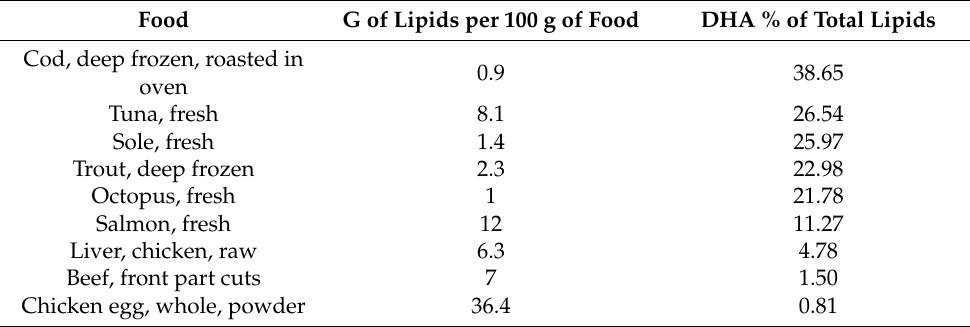
Table 4. Docosahexaenoic acid (DHA) content of some fish/seafood and animal meat. Food G of Lipids per 100 g of Food DHA % of Total Lipids Cod, deep frozen, roasted